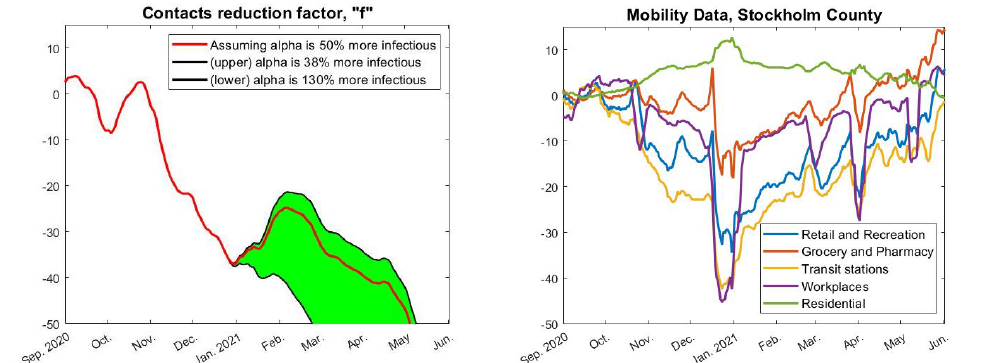
Figure 4. ( Left ): relative change in daily contacts needed to obtain a good fit with real data. The green area accounts for uncertainty about how much more contagious the alpha-strain was. The red central curve assumes 50% more contagious (following [16]), and the (almost perfect) data fit in Figure 3 (pink curve) is computed based on this. ( Right ): actual reduction in mobility pattern according to Google Mobility Data. Notice that the y-axis is the same in both the left and the right image, and that one would expect to see similar curves given that Hypothesis 1